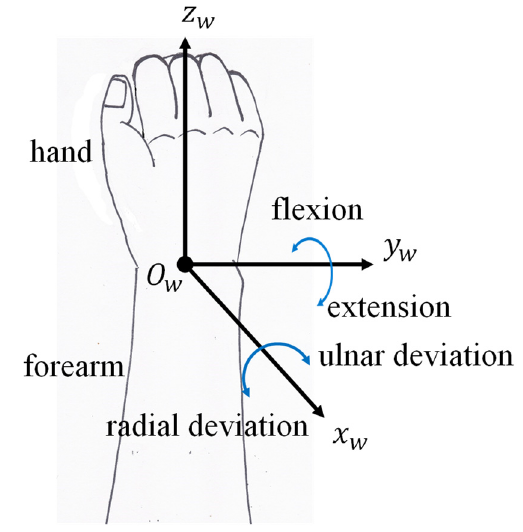
Figure 2. The target movement of wrist: FE and RUD movements [13]. Reprinted with permission from ref. [13]. 2021, Jc-IFToMM.